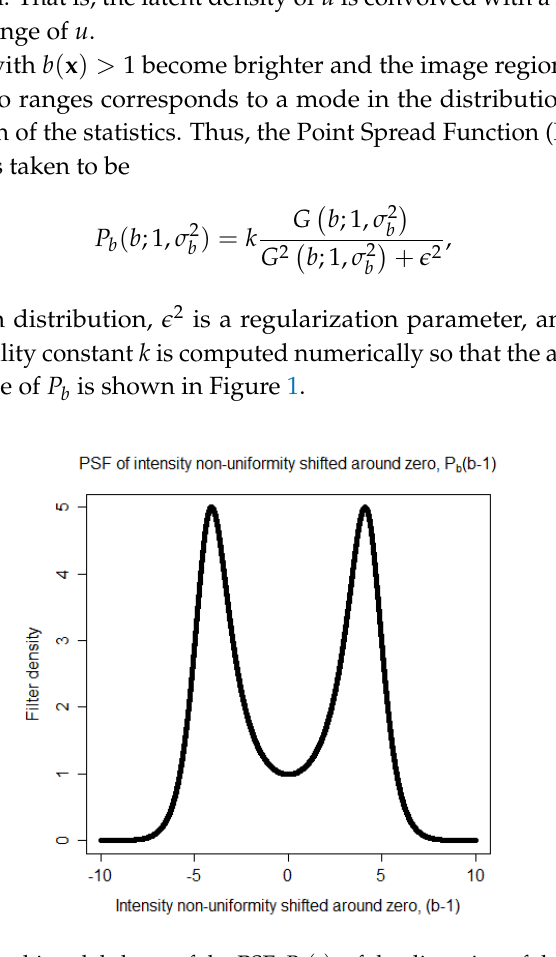
Figure 1. The bimodal shape of the PSF, P b ( · ) , of the distortion of the